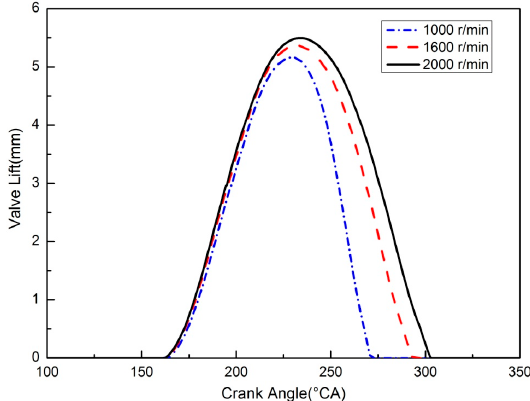
Figure 10. Valve lift curve at different rotational speeds.